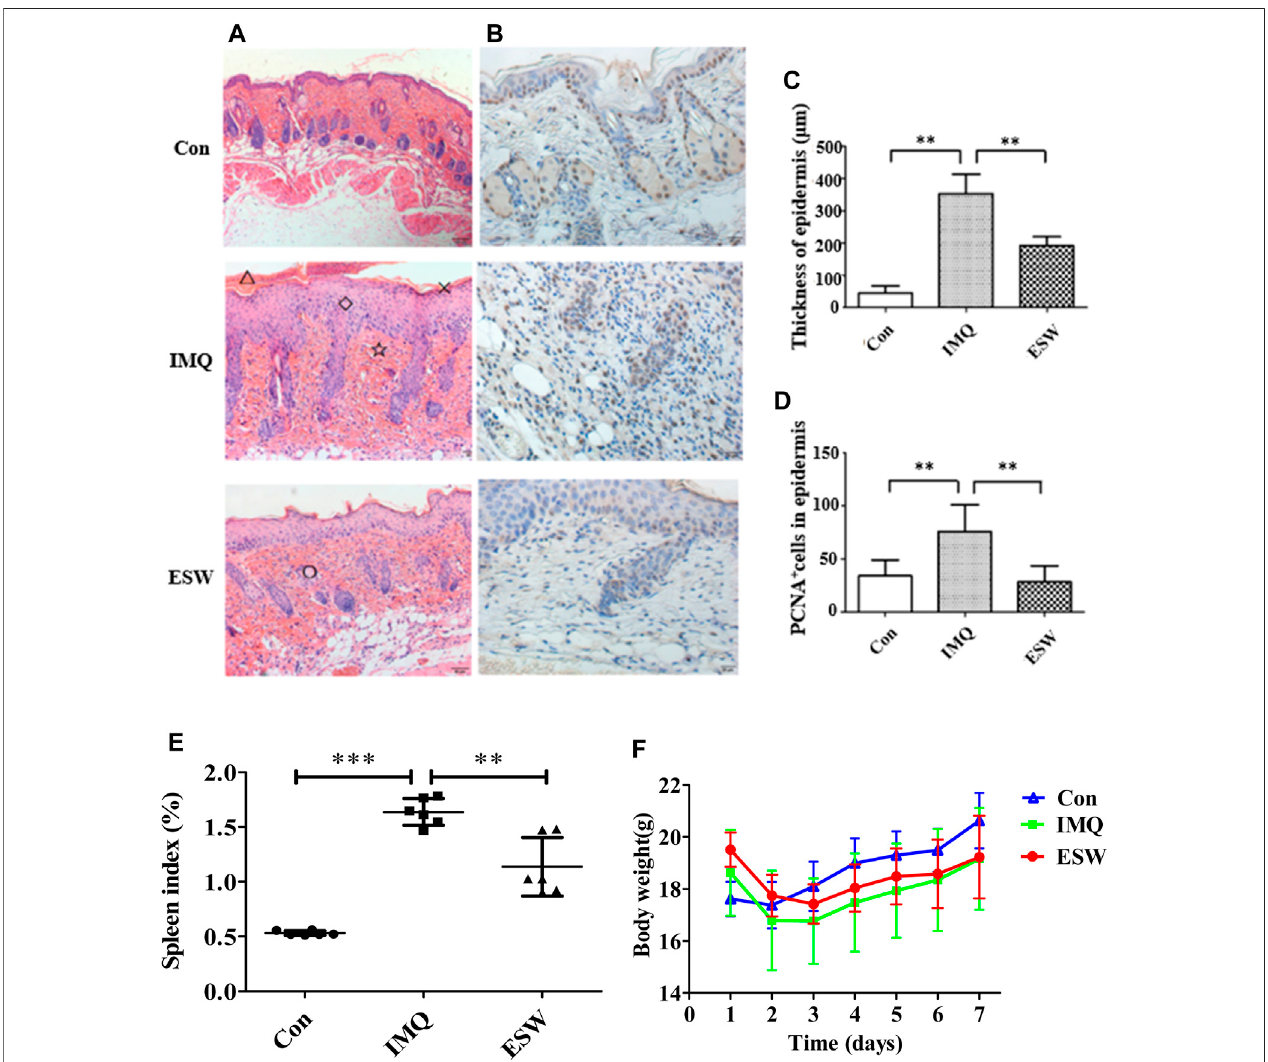
FIGURE 3 | (A) Histological evaluation of skin lesions (H&E staining, magni fi cation × 200); △ : microlimb swelling; × : parakeratosis; ◇ : acanthosis; q : lymphocyte in fi ltration; ○ :hairfolliclesandsebaceousglands. (B) Immunohistochemicalstaining( × 200)forproliferatingcellnuclearantigen(PCNA)(brown)inmousebackskin. (C , D) ThicknessofepidermalandPCNA + cellsoftheskinsectionsofmicefromeachgrouponday7. (E) Histogramofthespleenindexofeachgroup. (F) Bodyweightchange in each group from day 1 to day 7. Results were shown as the mean ± SD. ** p < 0.01 or *** p < 0.001 vs. IMQ group.